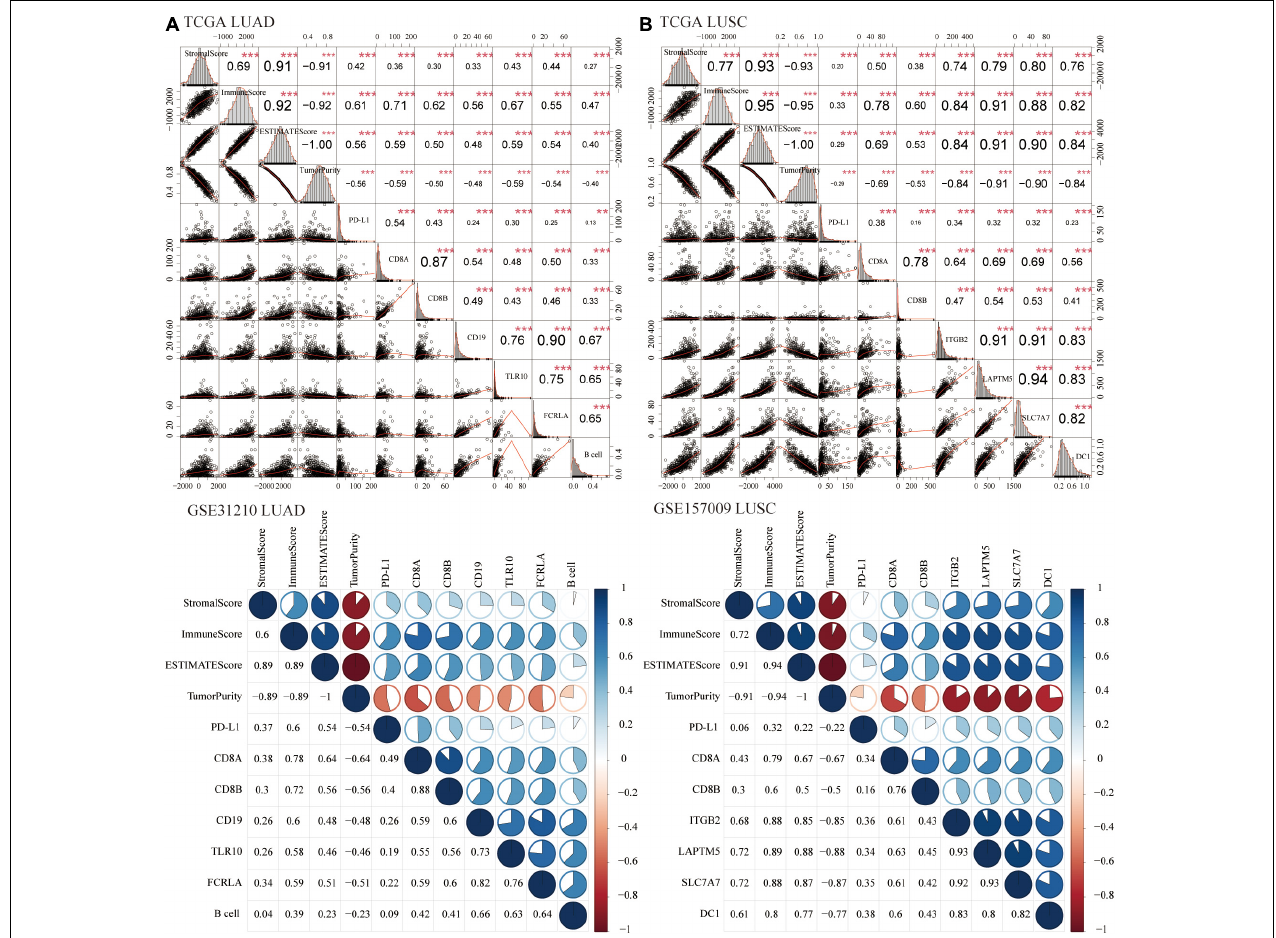
FIGURE 9 | Correlation with the overall tumor microenvironment (TME) score. For LUAD (TCGA and GSE31210) (A) and LUSC (TCGA and GSE157009) (B) patients, PD-L1, CD8A, CD8B, six hub genes, B cell, and DC1 were significantly positively related to the stromal score, immune score, and ESTIMATE score, whereas they were negatively associated with tumor purity. ** P < 0.01, *** P <